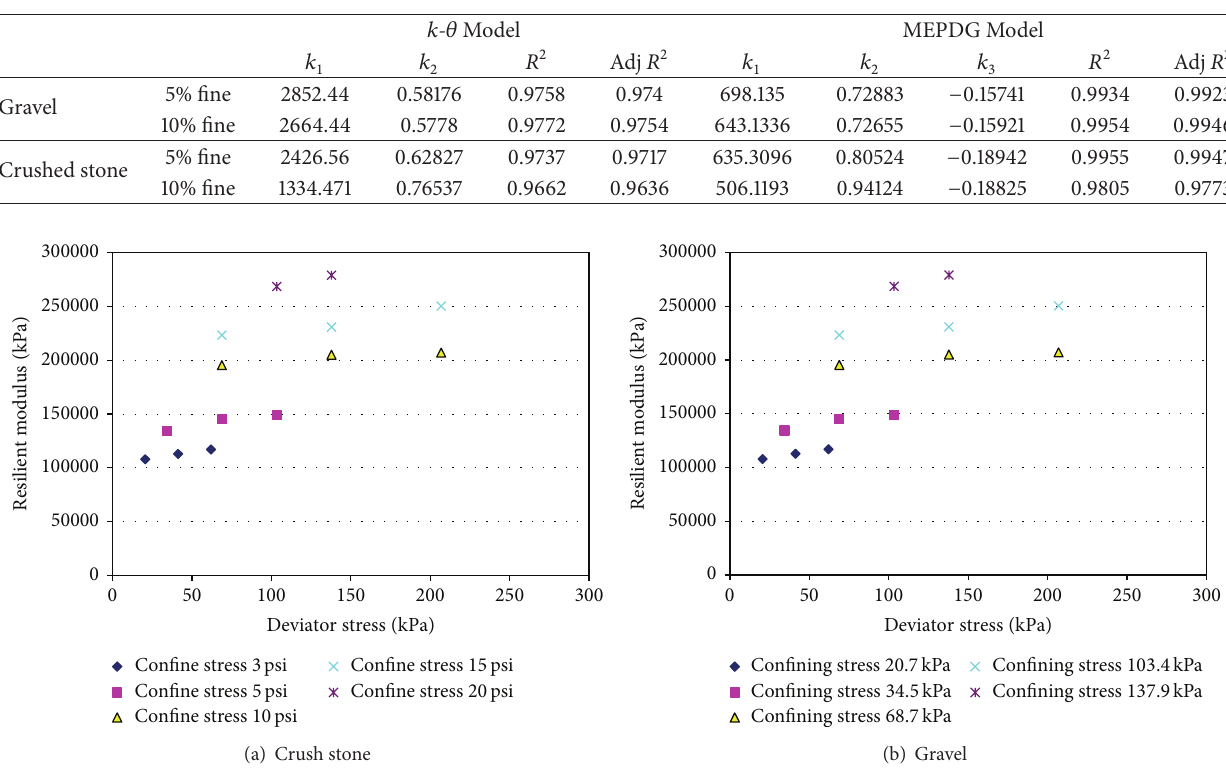
Table 4: 𝑘 - 𝜃 Model versus MEPDG Model.